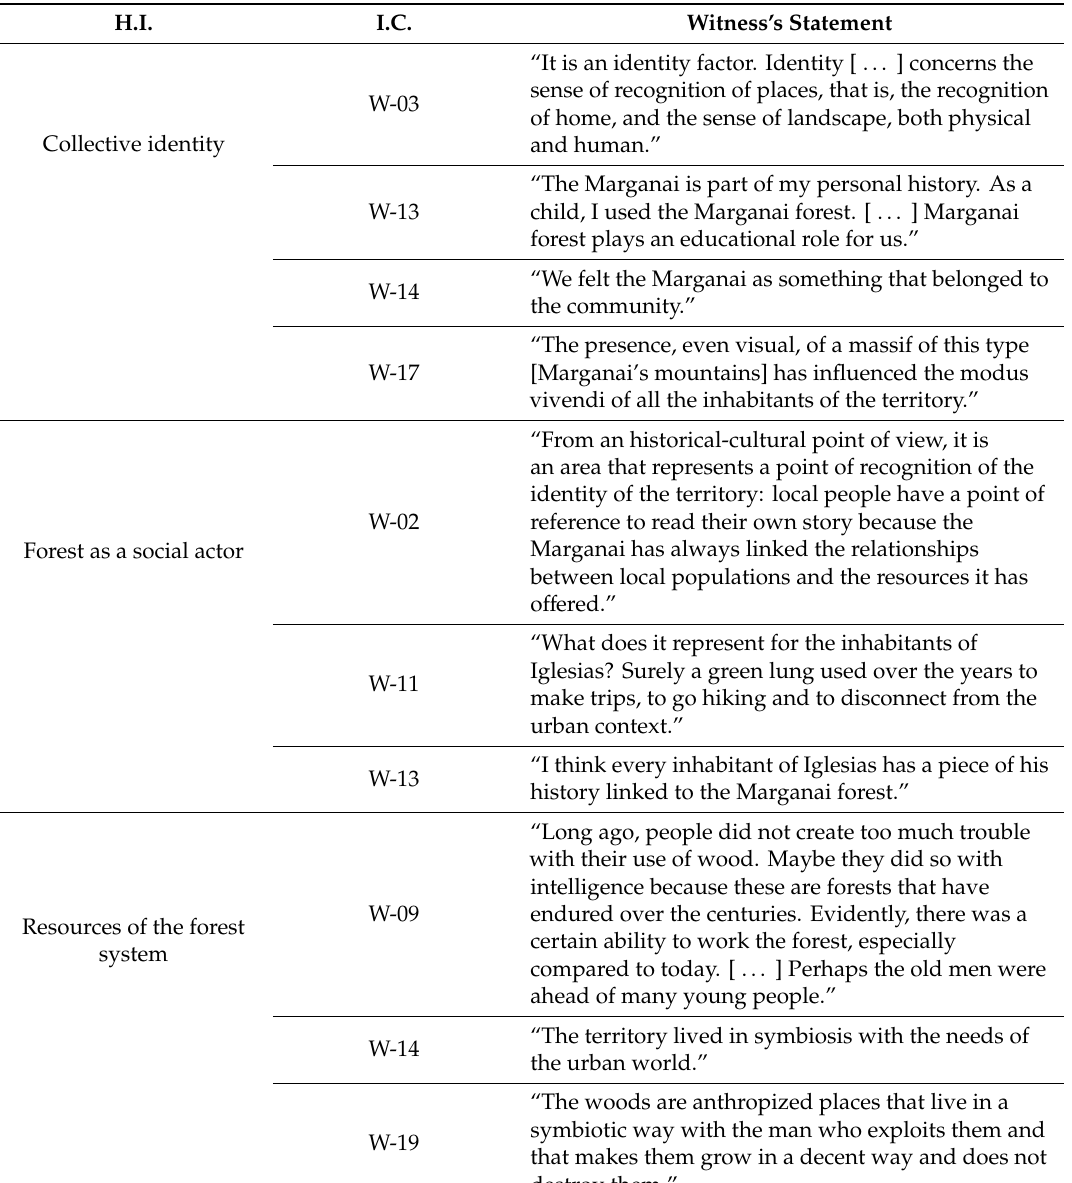
Table 3. Examples of homogeneous information (H.I.) about the dimensional analysis of the historical and identity functions of the